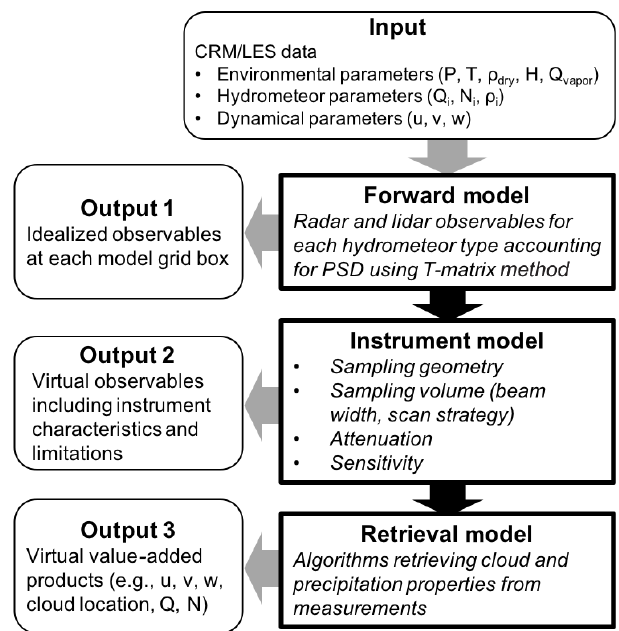
Figure 5. Diagram for CR-SIM and its applications. The diagram indicates the CR-SIM input and the different levels of output for the forward model, instrument model, and retrieval